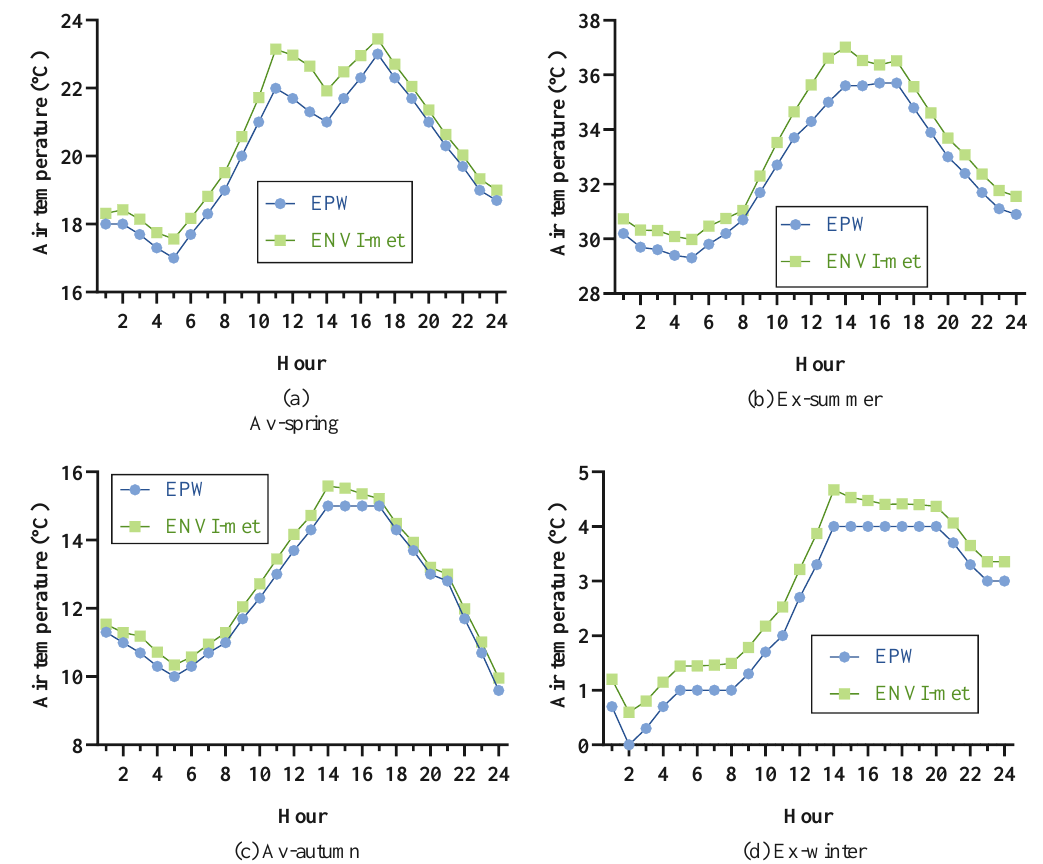
Figure 12. ENVI-met simulation results for the four representative days at the height of 3 m of the north receptor. Table 7. UHII max and UHII av at the height of 3 m of the north receptor.